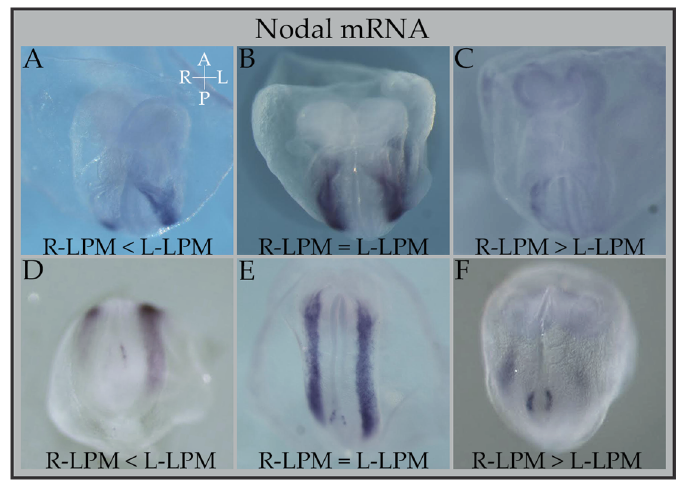
Figure 2. Differential Anterior-posterior bilaterality of Nodal expression in Cerl2 knock-out (KO) embryos. Bilateral expression of Nodal in the lateral plate mesoderm of Cerl2 KO embryos (50% display bilateral expression: left isomerism) at about E8.0 – E8.5 (from 2 to 7 somite pairs). This bilateral expression can be equal in the left or right LPM occupying the totality of both LPMs (panels B , E ); or it can be bilateral only in a more posterior or anterior area (panels A , C , D , F ). This partial bilaterality can be either more preponderant on the R-LPM (panels C and F ) or on the L-LPM (panels A , D ). Partial bilaterality is set early on as can be seen in panel F (2–3 somite embryo), and will last until the end of Nodal ’s expression in the LPM, at about 7 somites (as can be seen in panel C ). Embryo axes coordinates are present in panel A , in white letters: A: anterior; P: posterior; R: Right; L: Left. R-LPM (right—Lateral Plate Mesoderm); L-LPM (left—Lateral Plate Mesoderm).